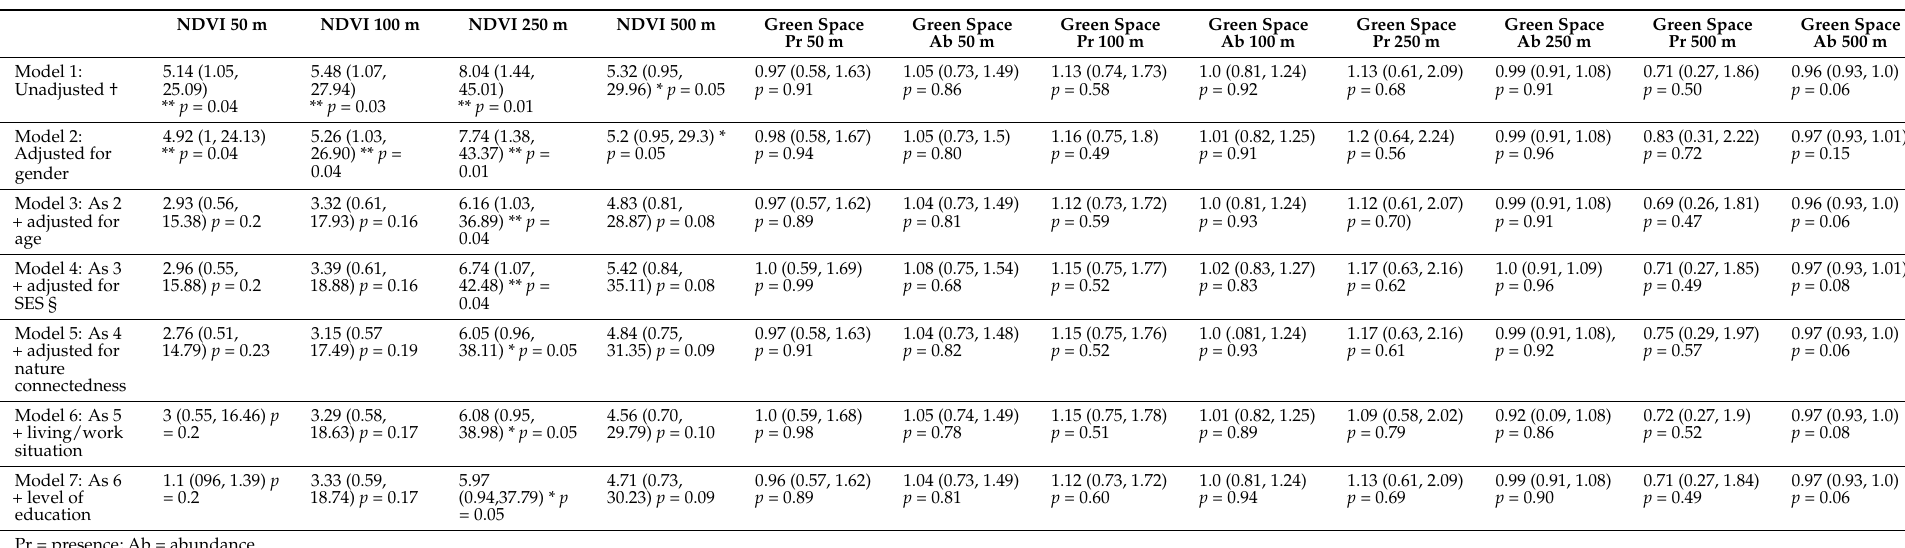
Table 4. Association between NDVI, green space presence and abundance, and self-reported mental wellbeing during the COVID-19